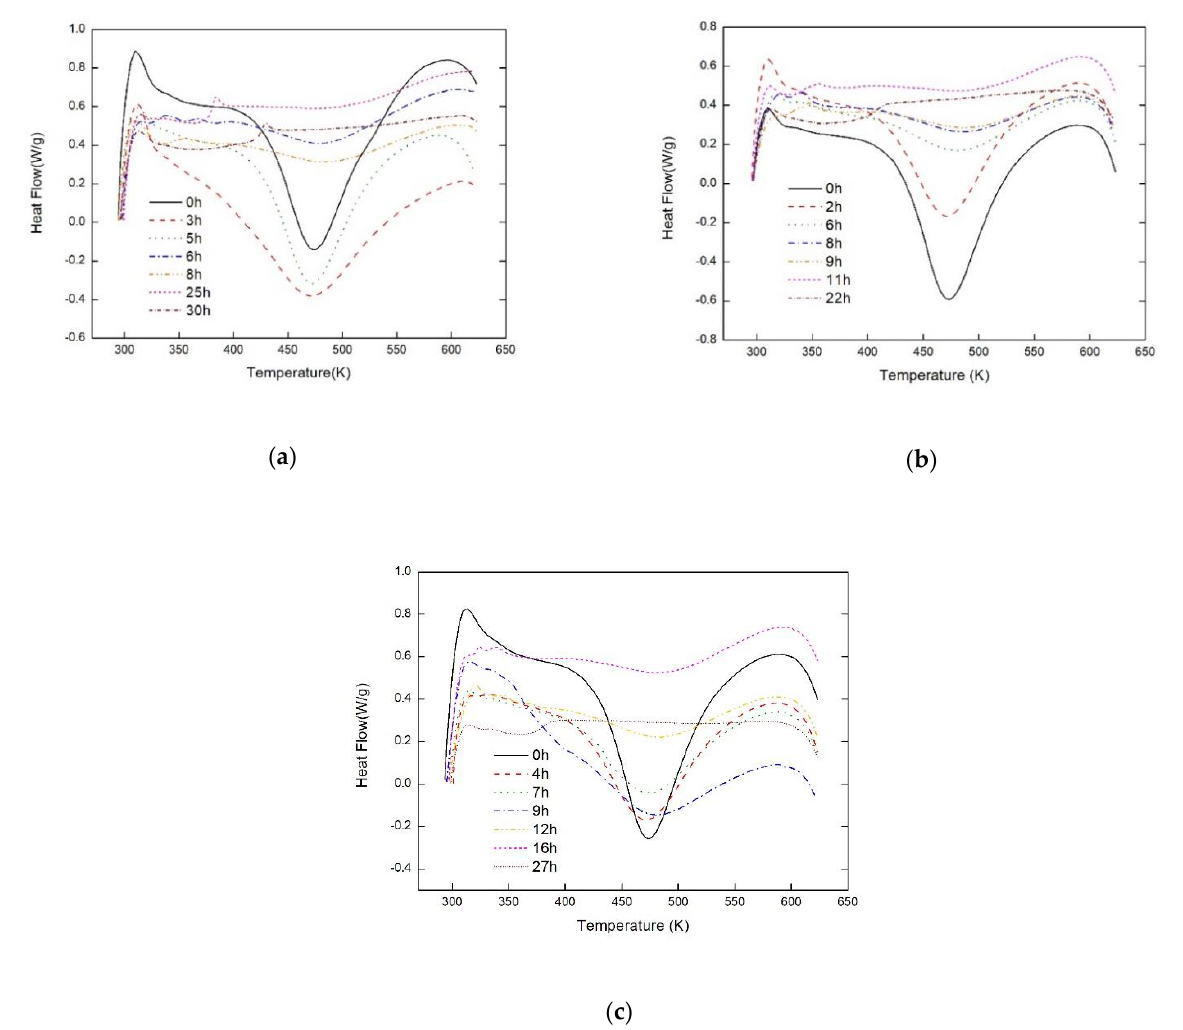
Figure 5. Non–isothermal DSC curves of curing reaction for epoxy system on different processes, ( a ) Process I, ( b ) Process II, and ( c ) Process III.